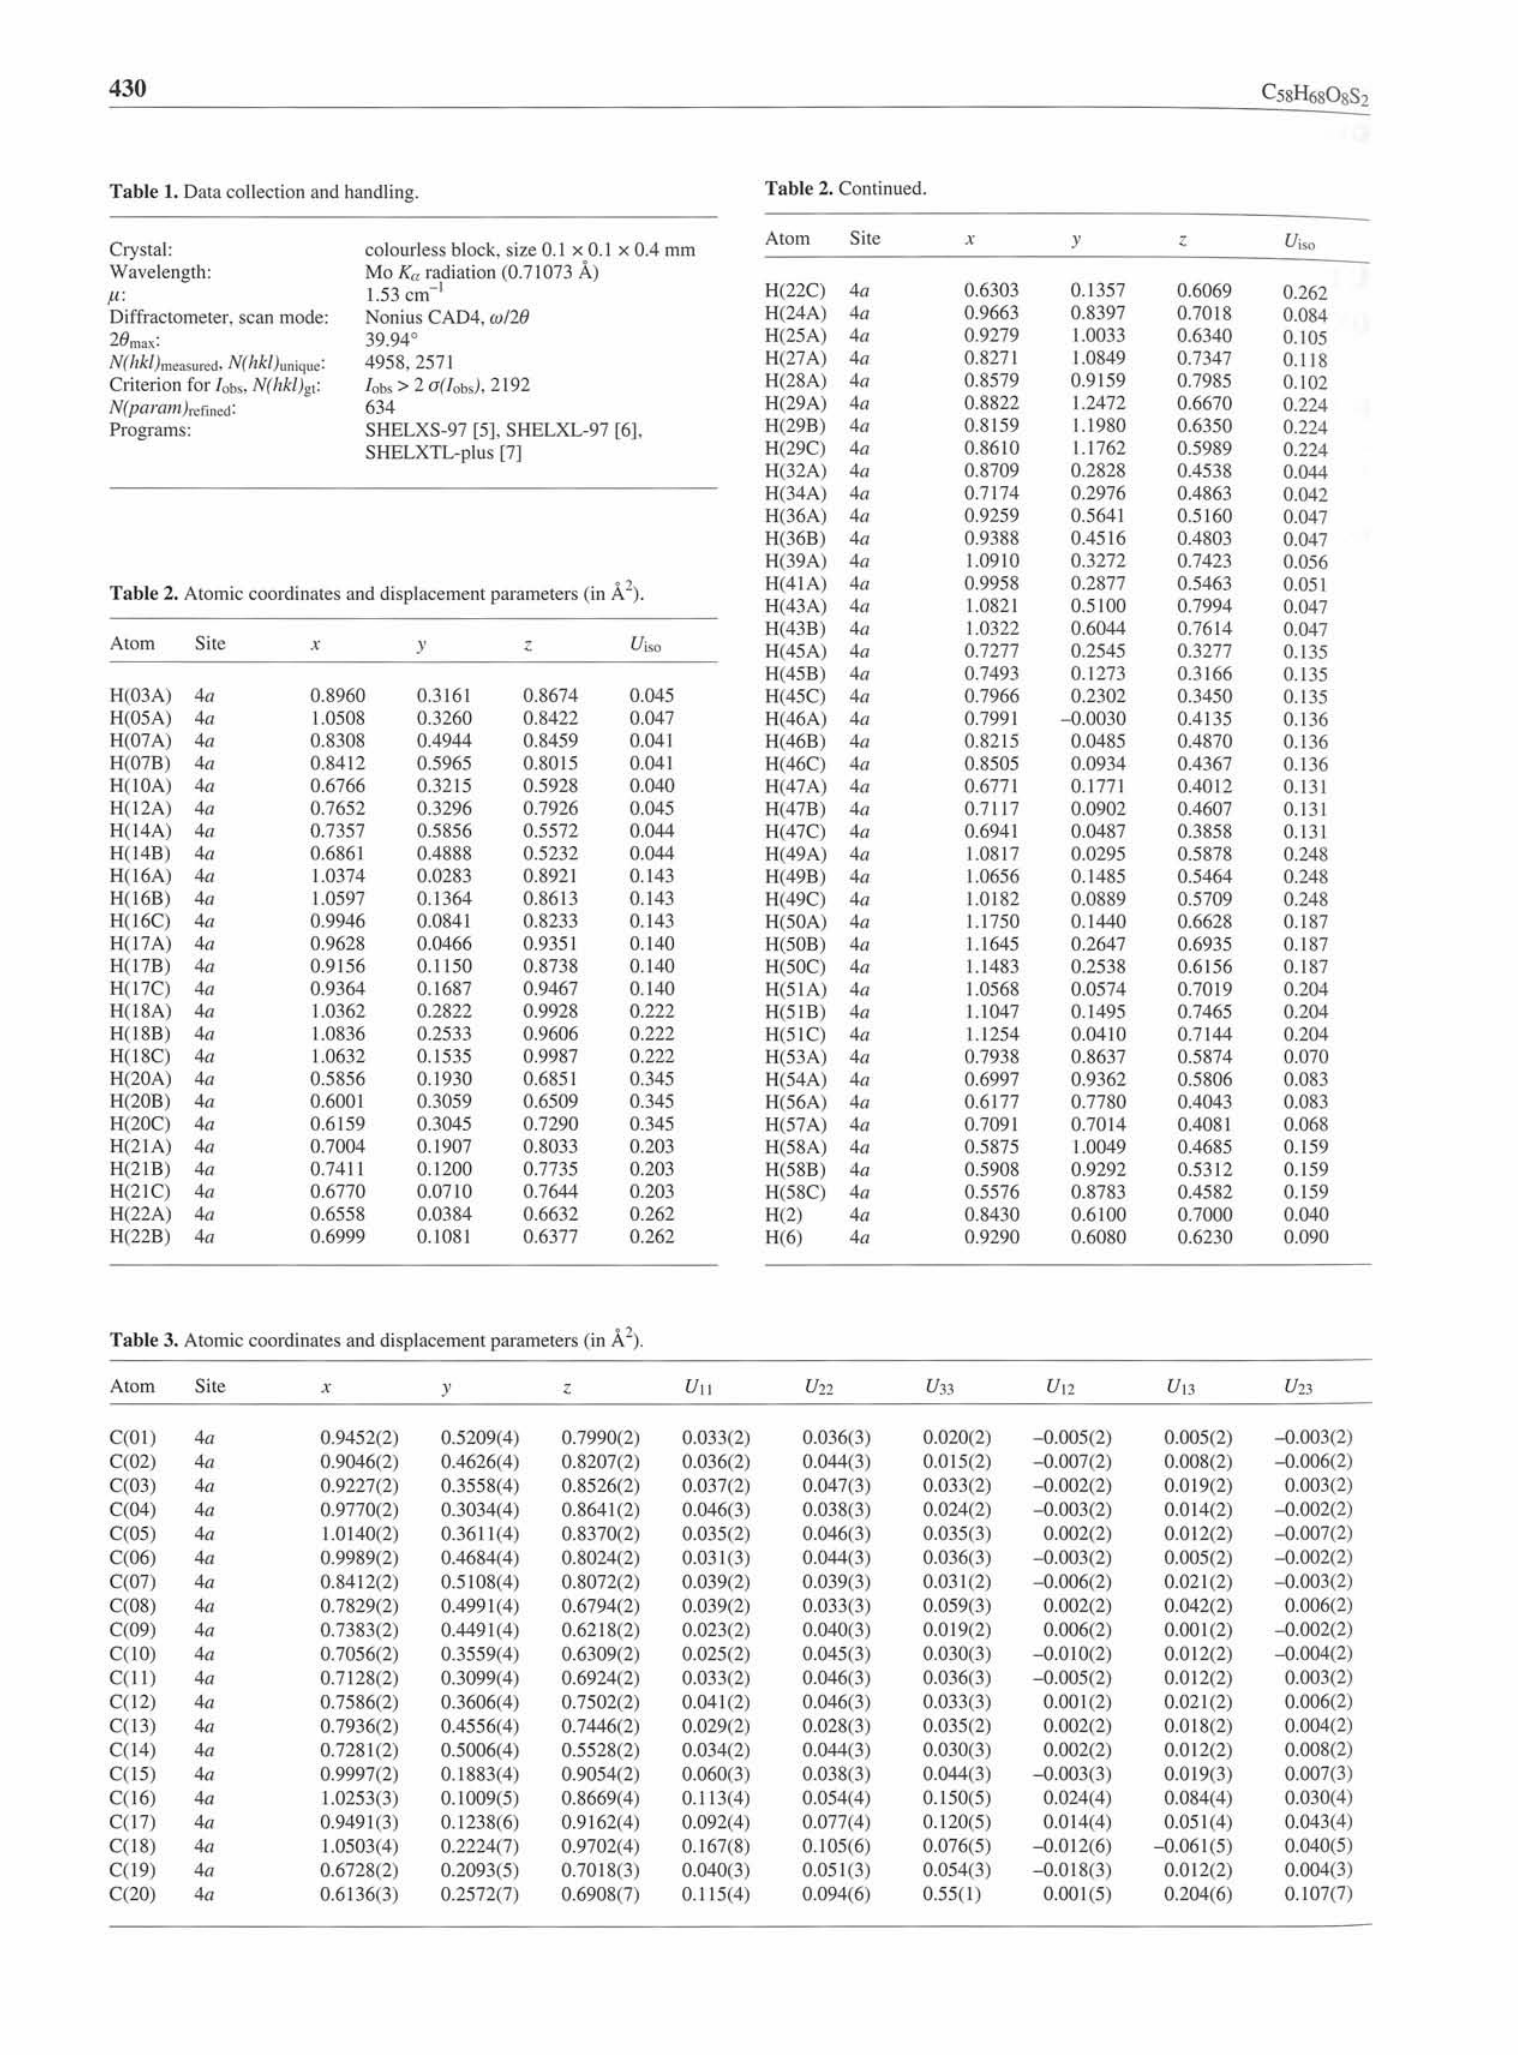
Table 2. Atomic coordinates and displacement parameters (in Â~).